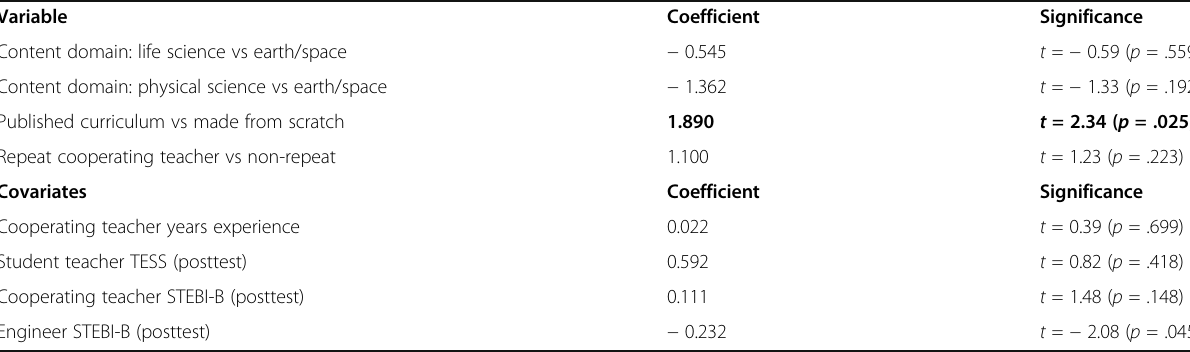
Table 7 Results from ordinal logistic regression model